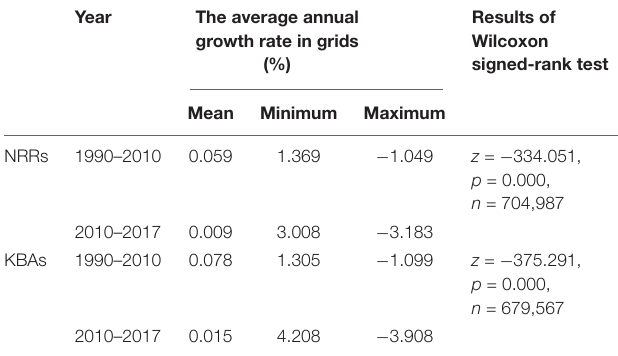
TABLE 4 | The variation of average annual growth of human pressure between 1990–2010 and 2010–2017.